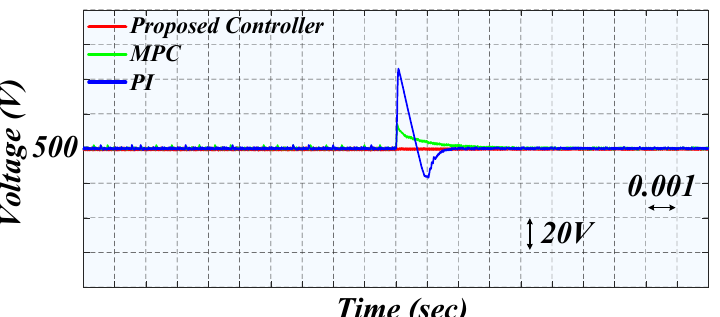
Figure 11. Comparison of the voltage transient responses of the proposed MF-NIBC controller, MPC, and the conventional PI controller during a step change in the output power in the third scenario.